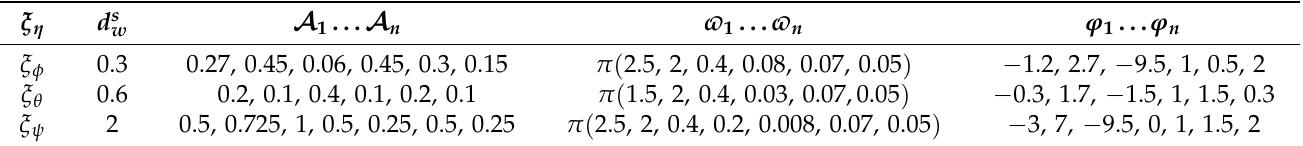
Table 5. Values for simulated torque disturbances.